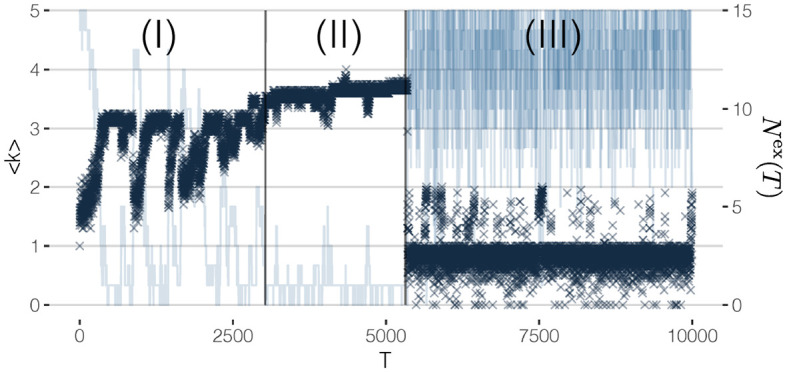
Evolution of mean coreness and number of rewired nodes for each time step in a 20-nodes network. Three regions can be identified: (I) Build up, (II) Metastable state, (III) Breakdown.